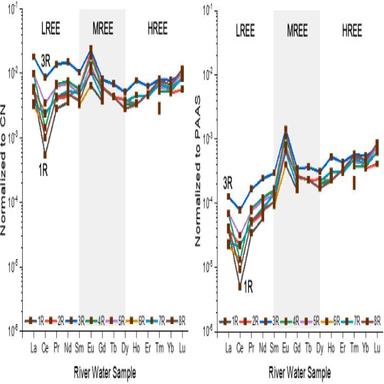
Spider-web diagrams of REE concentrations of the river water samples normalized by chondrite (CN) and PAAS. HREE enrichment by strong hydrothermal alteration of material surfaces in the groundwater is revealed more clearly by PAAS normalization (right).